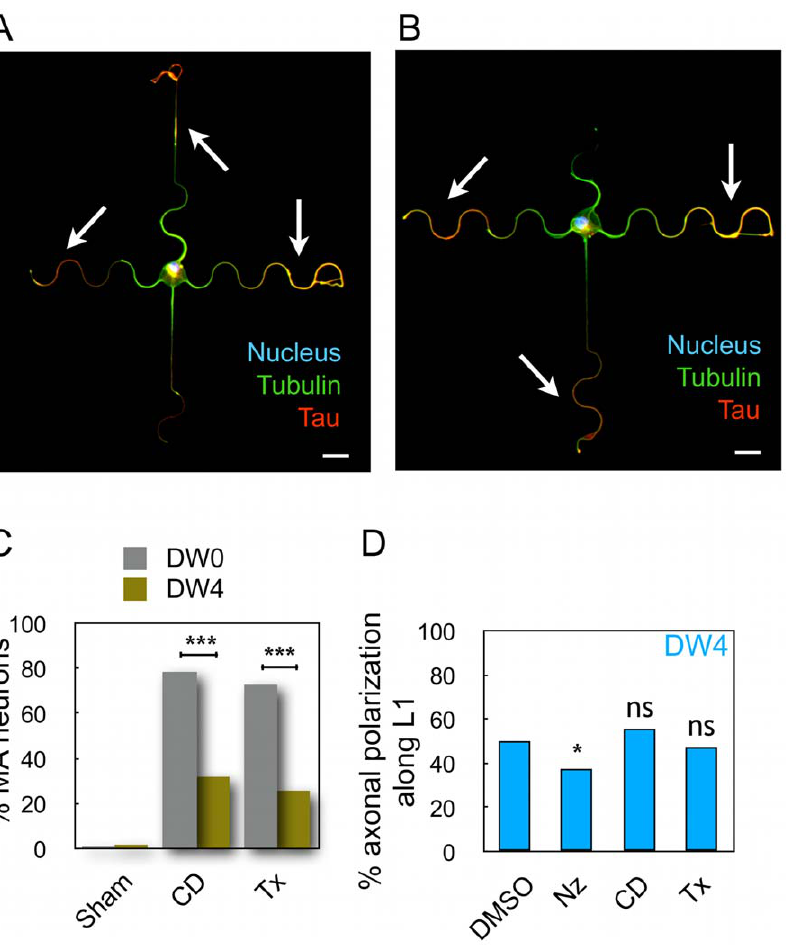
Figure 6. Combined action of drugs and micropatterns on axonal polarization. (A–B) Immunolabeling of stage 3 neurons on DW4 patterns grown in the presence of 0.5 m M cytochalasin D (A) or 3 nM taxol (B): axon (tau staining, red), microtubules (tubulin staining, green) and nuclei (Hoechst staining, blue). Both drugs induced multiple axon (MA) formation as revealed by a tau positive staining of several neurites (white arrows). Scale bar, 20 m m. (C) Percentages of multiple axon (MA) neurons grown over DW0 or DW4 micropatterns, in sham conditions or in the presence of cytochalasin D (0.5 m M) or taxol (3 nM); (sham n =117; CD, n =112; Tx, n =150 for DW0 and sham n =109; CD, n =153; Tx, n =319 for DW4). ***, significantly different from DW0, p , 0.001. (D) Axonal preference along L1 for neurons grown on DW4 micropatterns, in the presence of DMSO, 45 nM nocodazole (Nz), 0.5 m M cytochalasin D (CD) or 3 nM taxol (Tx) ( n =107, 146, 104, and 237 neurons with a unique axon, respectively). Blue dotted lines represent the predicted preference along L1 in the presence of CD or Tx as determined with the probabilistic model (Text S1). *, significantly different from the expected distribution, p , 0.05.